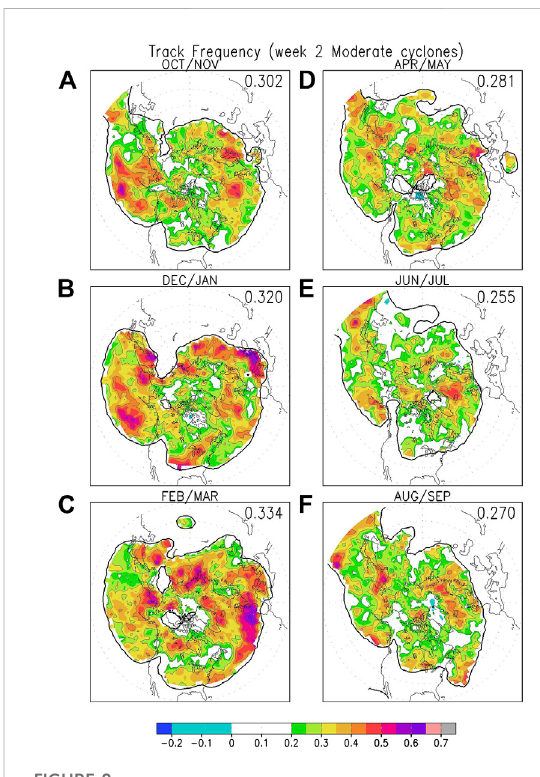
FIGURE 8 Same as Figure 6, but for week 2 hindcasts of cyclone track frequency of moderate cyclones with central SLP < 1000 hPa.